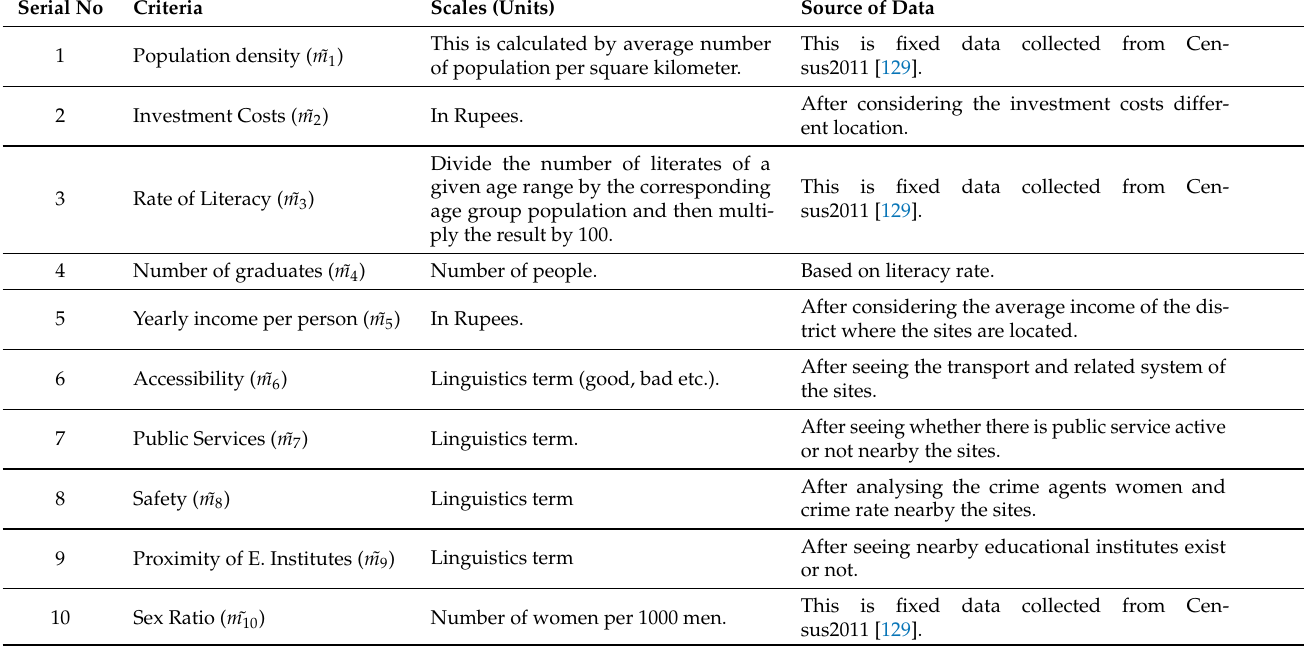
Table 10. Related criterion’s with their units and data